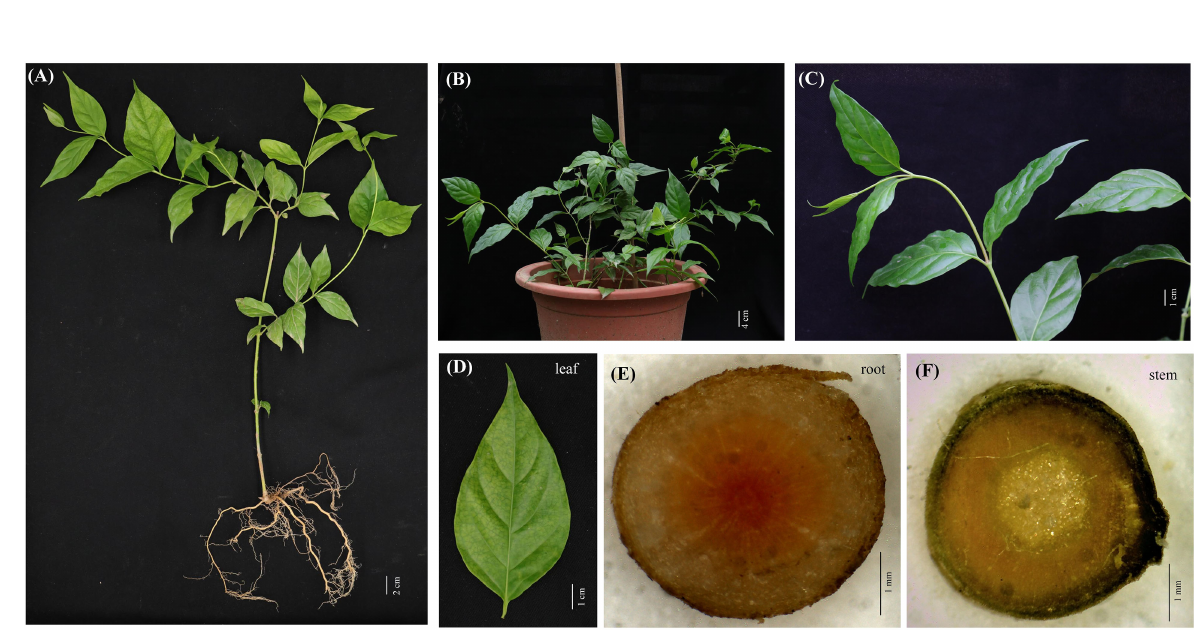
FIGURE 1 G. elegans plants cultured in pot. (A – C) The mature stage of G. elegans . (D) The leaf of G. elegans. (E) The root cross-sections. (F) The stem